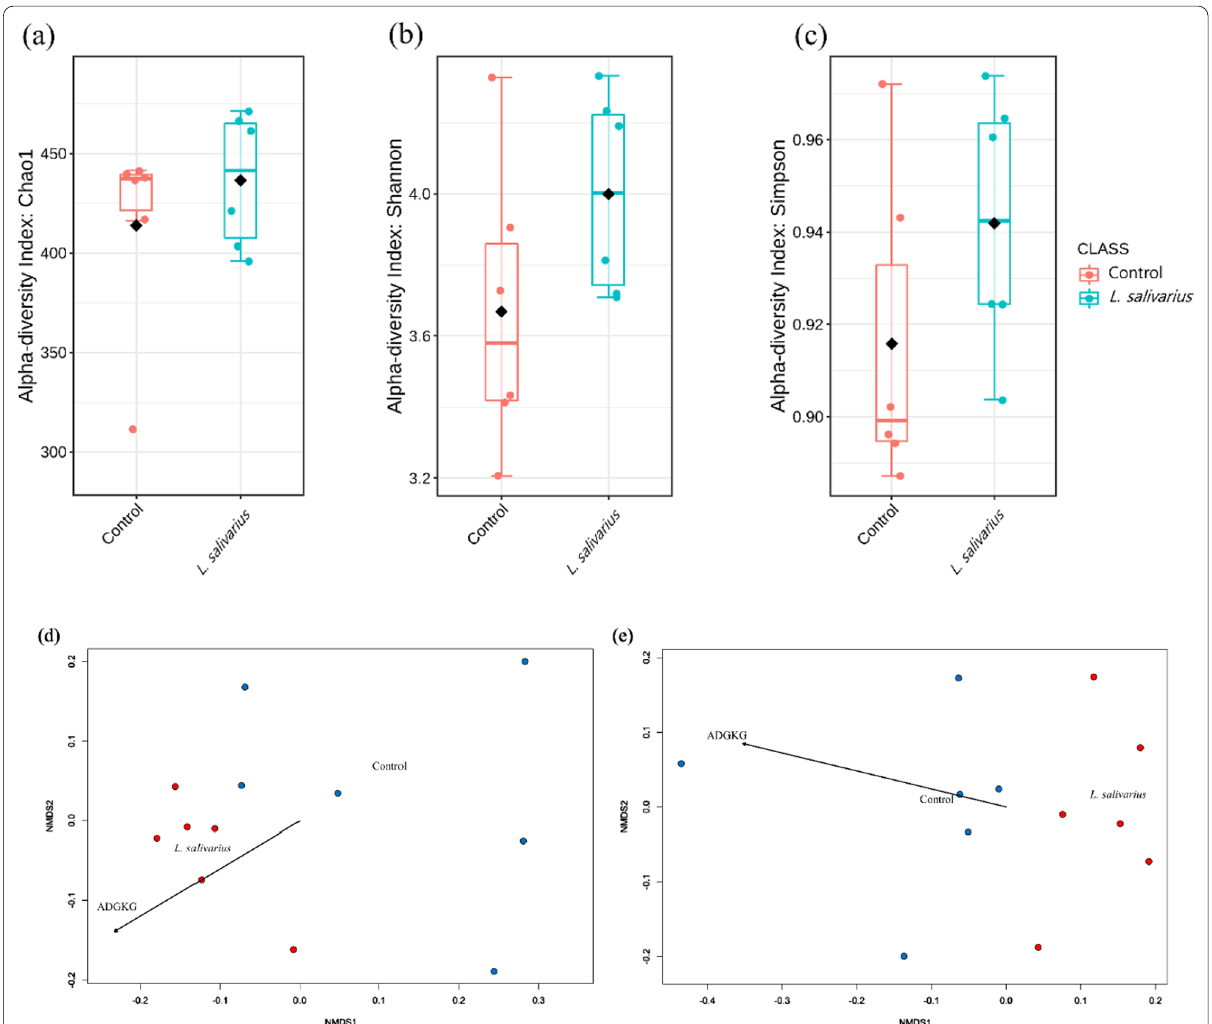
Fig. 1 Microbial richness and diversity. Comparison of the alpha-diversity indices a Chao1, b Shannon, and c Simpson and the beta-diversity indices of each group in weighted d and unweighted e NMDS plots of UniFrac distances of samples in two groups (control and heat-killed L. salivarius